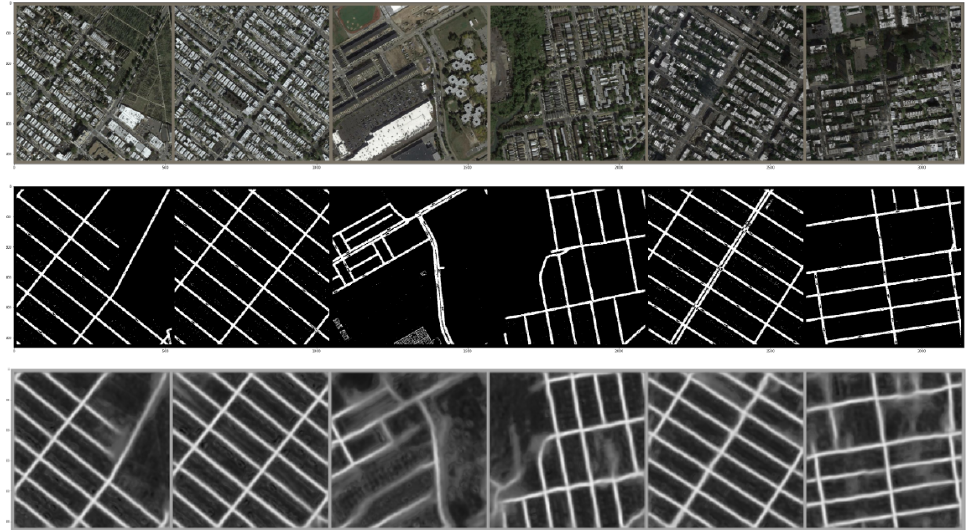
Figure 6. U-net++ with ResNeXt trained on Pix2Pix dataset with 2-stage training strategy. The first row and second row represent the input and ground truth, respectively. The last row represents the model